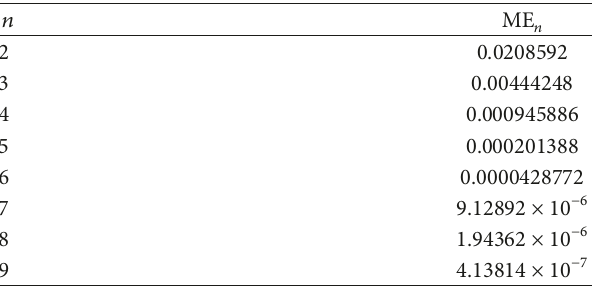
Figure 11: Logarithmic plots of the maximal errors ME 𝑛 versus 𝑛 for 𝑛 = 2 through 9 obtained by the Duan-Rach modified ADM. Table 3: For 𝛼 = 4 , maximal errors ME 𝑛 for 𝑛 = 2, 3,. . . , 9 obtained by the Duan-Rach modified